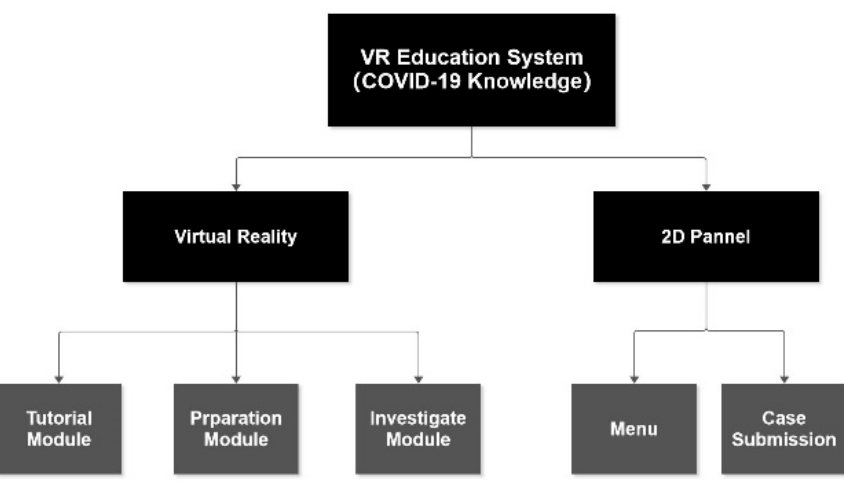
Figure 7. System Function Modules.